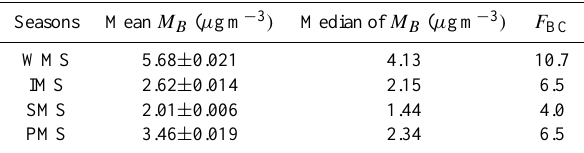
Table 5. The mean and median values of black carbon mass con- centrations ( M B ) observed in each seasons and the mass fraction of black carbon ( F BC ) to the total aerosol